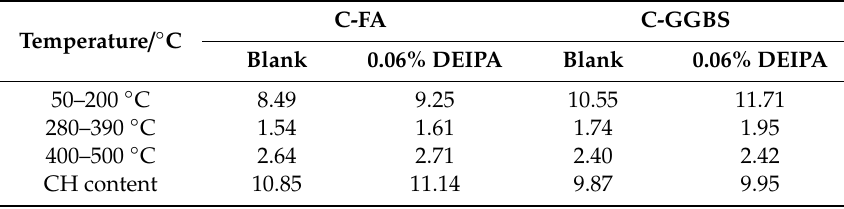
Table 4. Loss weight of C-FA and C-GGBS samples cured for 7 d.